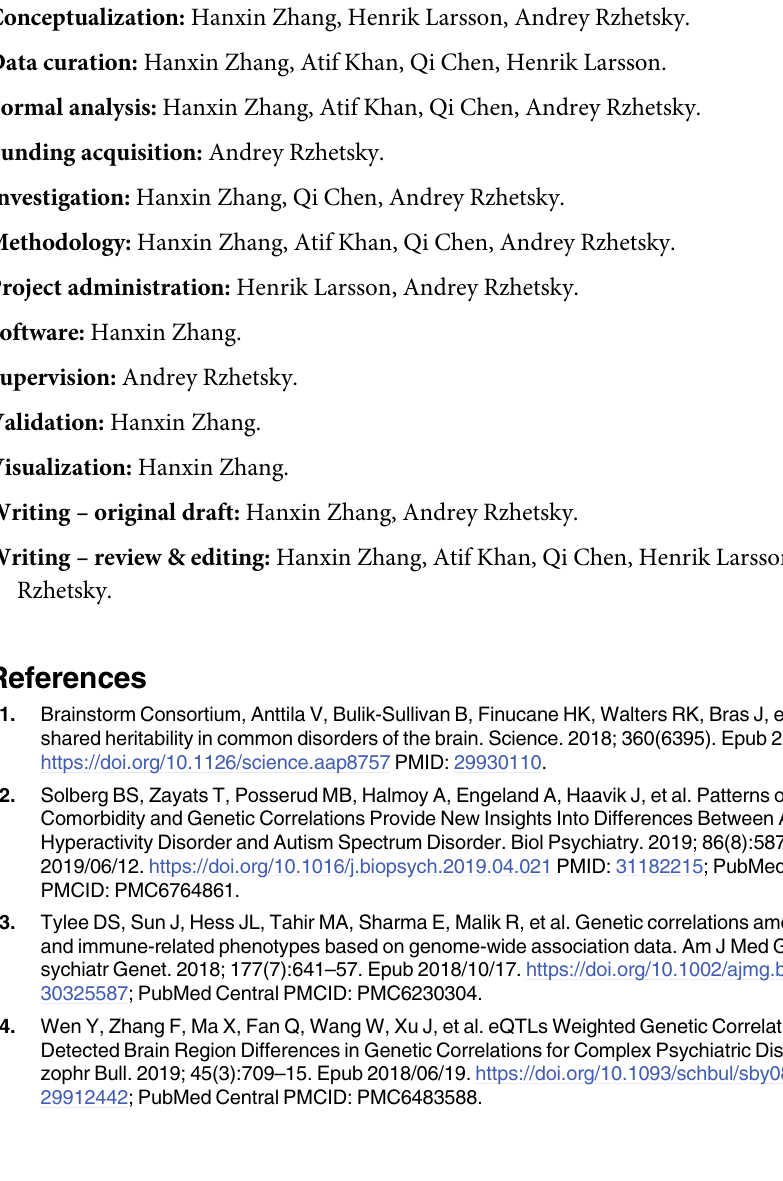
S13 Fig. The model selection for choosing the number of harmonics. The model with N = 5 has the lowest sum of WAIC over 33 psychiatric and 47 infectious diseases. It suggests the sim- pler model is good enough to model disease seasonality. In the example of depression in young males, adding up harmonics would not help the estimation, given the intrinsic simplicity of seasonality. The data underlying this figure can be found in https://doi.org/10.5061/dryad. vdncjsxv6. WAIC, Watanabe–Akaike information criteria.